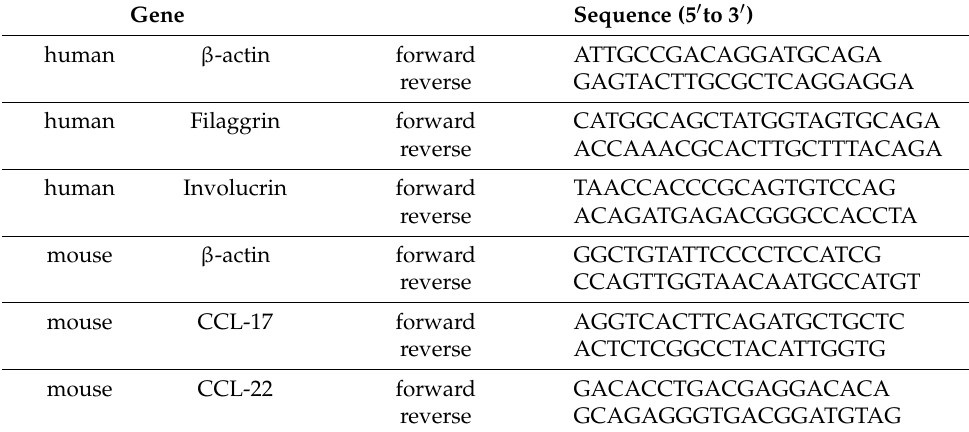
Table 1. The sequences of primer.